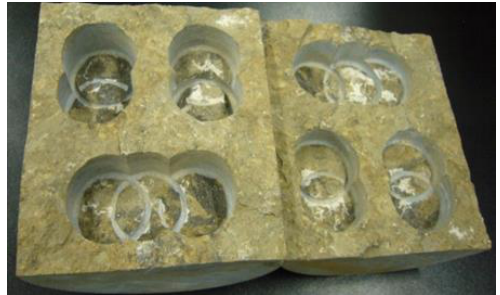
Figure 2. Photograph of artificial fractured-vuggy full-diameter core. Twenty-one sets of full-diameter core displacement experimental studies were de- signed for vertical depletion, horizontal depletion, the injection of dry gas to maintain pressure, the injection of water to maintain pressure, the injection of dry gas to refine the structure and the phased injection of water to maintain pressure (see detailed procedure in references [14,15]). The water injection and pressure preservation in different stages refer to the step-like decline in the gas reservoir pressure. First, the dew-point pressure dropped by 10% to 50 MPa, then the water injection was maintained until the pressure was restored to the dew-point pressure, and finally the water injection was stopped after the collapse to 50 MPa, completing one-time water injection and pressure preservation. For the second time, the water injection was carried out until the formation pressure re- covered to the dew-point pressure and then collapsed to 50 MPa. After several rounds of water injection under a pressure of 50 MPa, the pressure of the gas reservoir reduced by 5 MPa, which became the pressure-preserving value (45 MPa) to carry out the water in- jections and preserve pressure preserving in the second-stage. The last stage of the water injection maintained a pressure of 30 MPa, and then it decreased to atmospheric pres- sure. In order to simulate the filling of the fracture cavity, we set up sand filling of the fracture and cave as the control experiment. The experimental process was divided into core vacuuming, dry gas injection and saturated condensate gas in the original for- mation conditions, and then the 21 sets of displacement experiments designed above were carried out successively. Water injection for oil replacement in a well of a fracture-cave reservoir mainly uses the difference in oil – water density to replace the injected water with formation oil via gravity differentiation. This aims to recover formation energy and drive crude oil to wellbore production. We took the procedure of “ water injection – soaking – oil recovery ” in oil wells as an injection cycle for production. This can gradually improve oil recovery through multiple rounds of water injection for oil replacement [18,19]. In gas fields, sim- ple equipment such as water injection pumps can be directed into the fracture-cave res- ervoirs. This technology has been applied in the northern oil fields. Considering the characteristics of the fracture-cave condensate gas reservoir with oil accumulating at the bottom of the fracture-cave reservoirs, the water injection production field test was car- ried out based on experiments assessing means of developing the water injection mech- anism as references [14 – 17]. The injection modes of the water were cyclic water injection in a single well and water flooding in a reservoir unit. Injected water was water pro- duced from adjacent wells . 4. Results 4.1. Experiments to Enhance Oil Recovery in Fracture-Cave Reservoir In the unfilled cores (Table 1), the experimental results show an oil recovery of 15.95% with horizontal depletion and 14.64% with vertical upward depletion to 10 MPa. It should be noted that oil recovery is 46.90% with vertical downward depletion. These results suggest that vertical downward depletion can obtain a much higher oil recovery